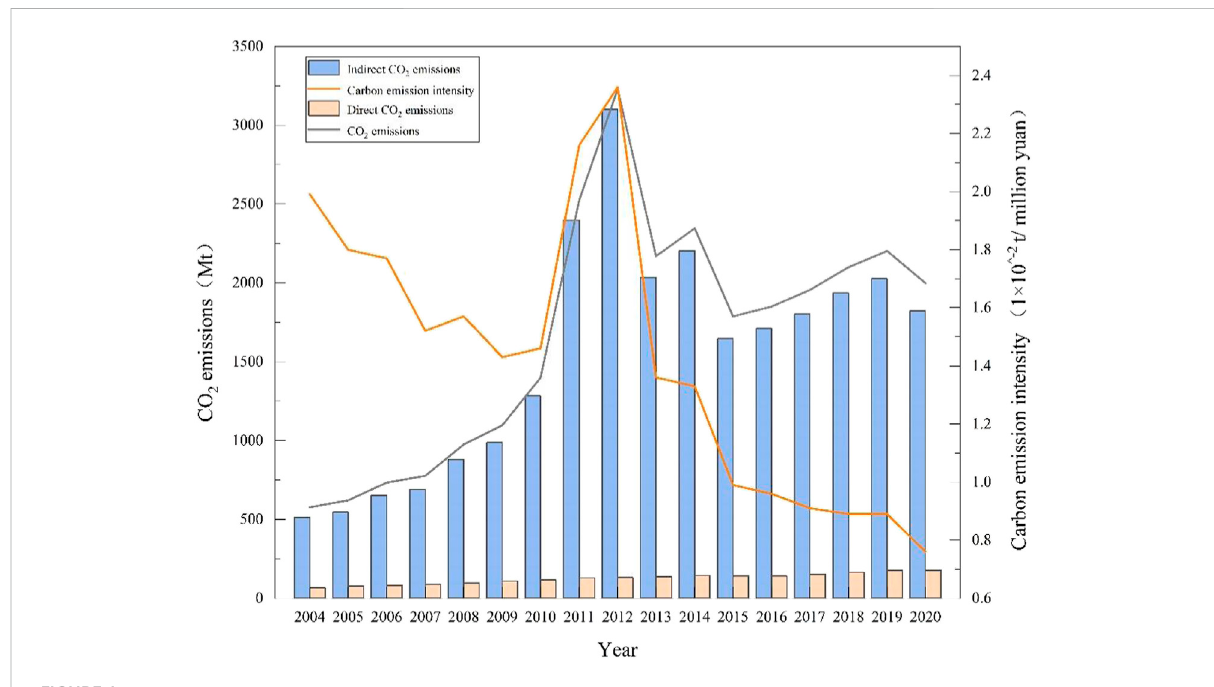
FIGURE 1 Estimation of CO 2 emissions from construction industry in China.